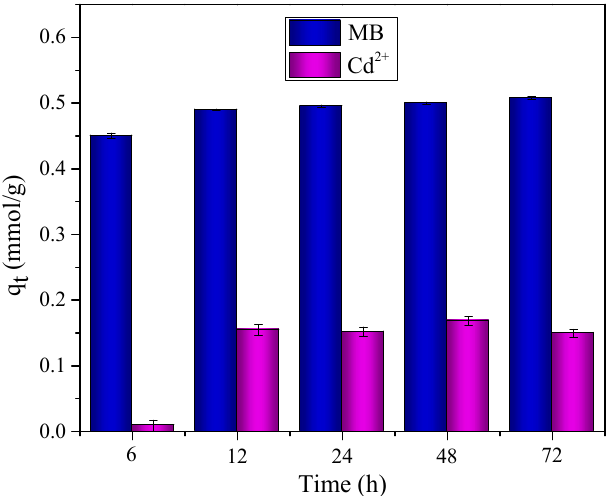
Figure 1. Optimum contact time for MB and Cd 2+ on the adsorbent material OP. Table 2. Isotherm parameters for MB and Cd 2+ adsorption on